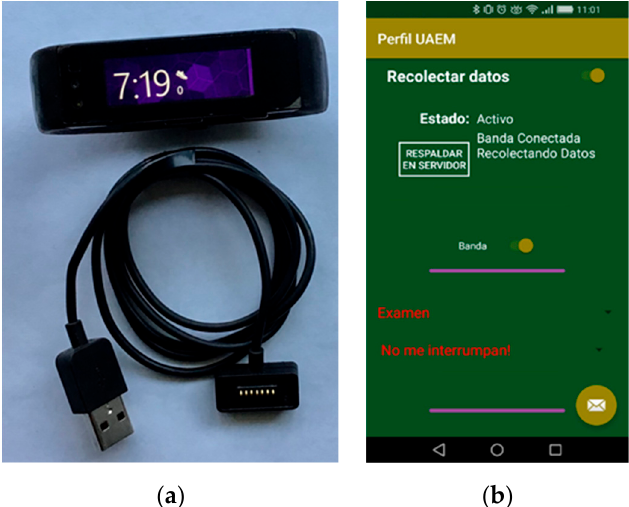
Figure 3. ( a ) Microsoft Band with screen guard protector and USB charger. ( b ) Screenshot of our Android App for data collection in the Spanish